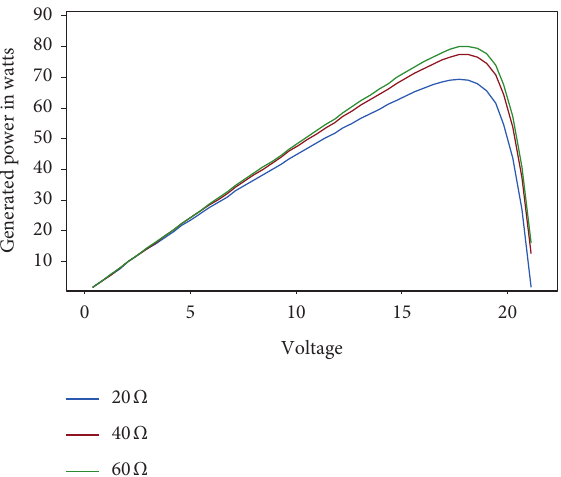
of solar cell. sh